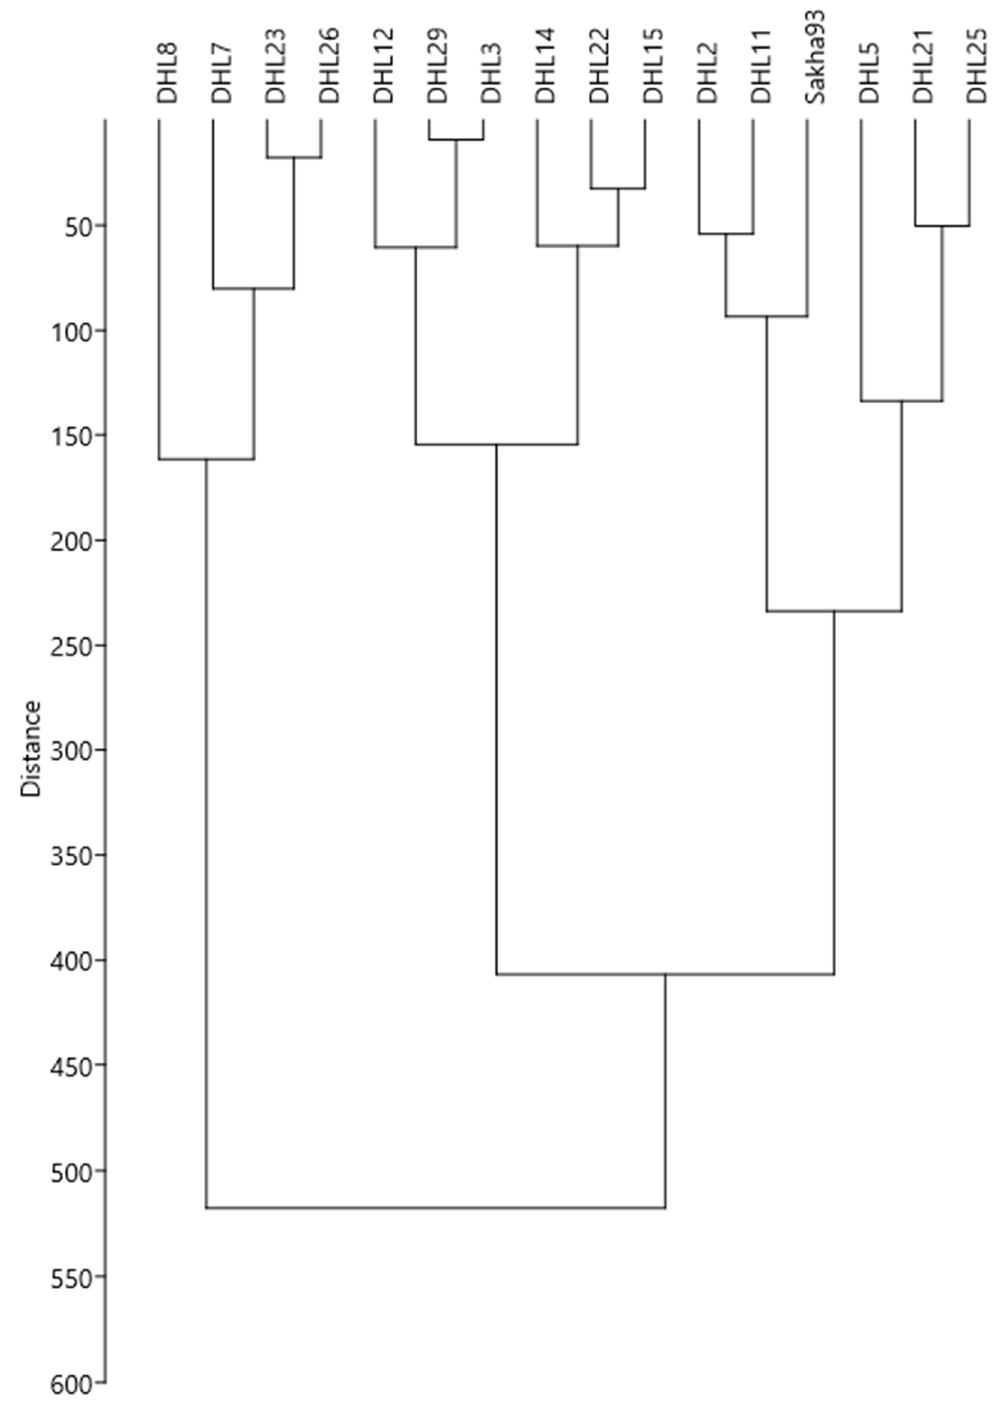
Figure 2. Dendrogram showing clustering of 16 wheat genotypes based on the Euclidean distance for 15 measured traits. DHL: doubled haploid line.